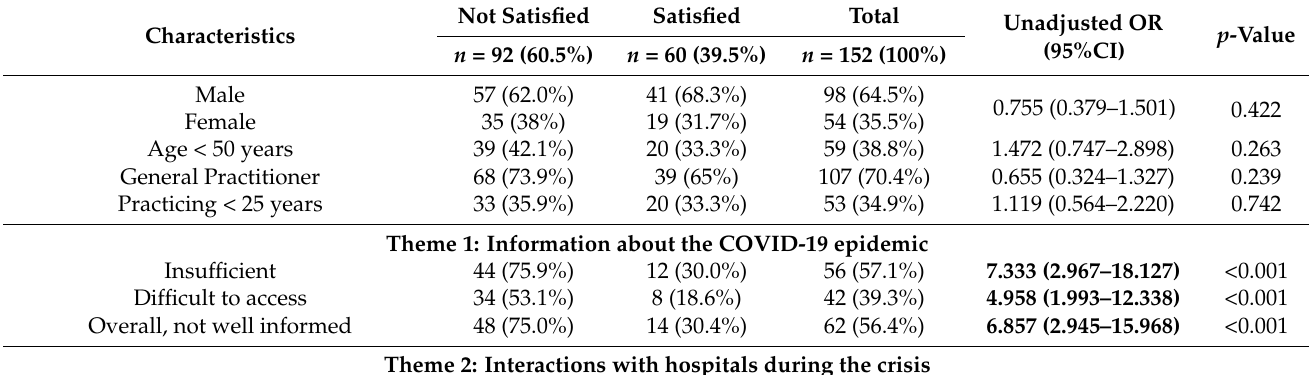
Table 1. Characteristics of the participants and the main results of the survey, according to